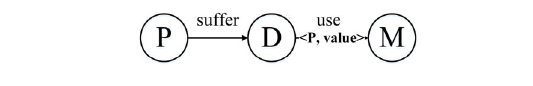
FIGURE 4 | Schema of patient-annotated